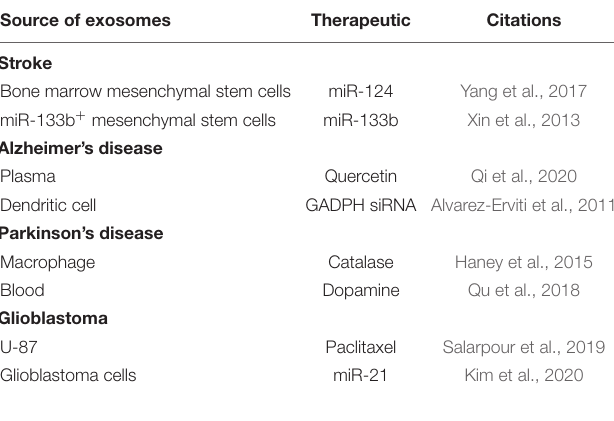
TABLE 2 | Select examples of drug delivery to the